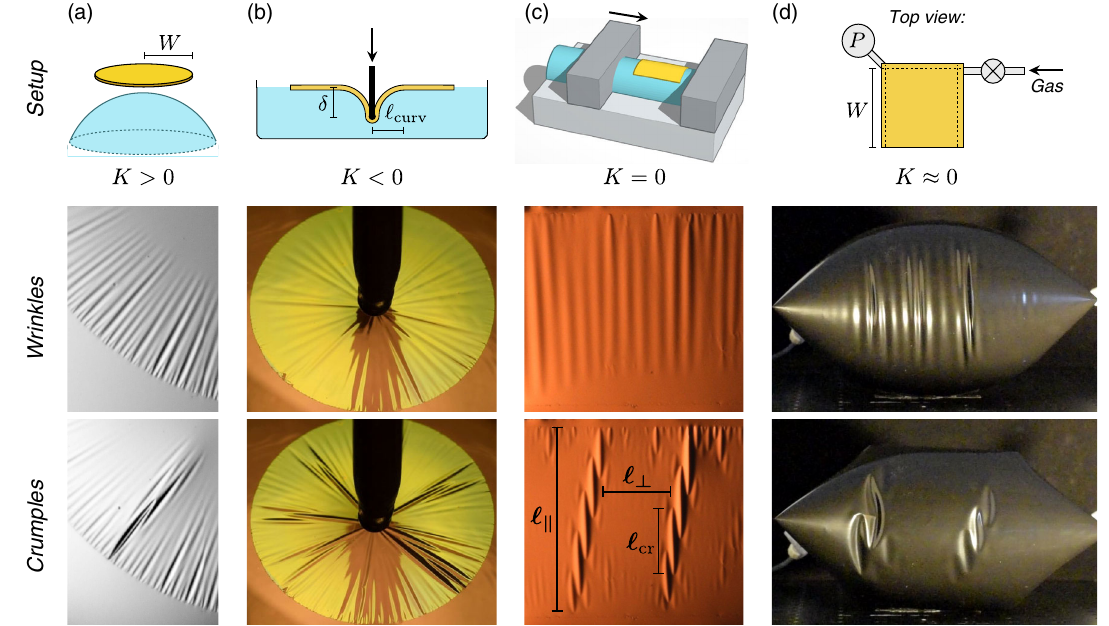
FIG. 1. Wrinkle-to-crumple transition in a wide range of geometries, boundary conditions, and system sizes. The overall Gaussian curvature K imposed on the relevant portion of the sheet is given below each schematic. (a) A circular polystyrene sheet ( E ¼ 3 . 4 GPa) of radius W ¼ 1 . 5 mm and thickness t ¼ 77 nm on a liquid meniscus forms crumples at a large droplet curvature [25]. Images adapted from Ref. [26] with permission. (b) A polystyrene sheet floating on a liquid bath forms crumples when indented beyond a threshold depth. Here, W ¼ 11 mm and t ¼ 436 nm. (c) Central portion of a rectangular polystyrene film of thickness t ¼ 157 nm, width W ¼ 3 . 3 mm, and length 9.7 mm on a water meniscus that is uniaxially compressed between two barriers. Wrinkles form when the meniscus is flat or gently curved; crumples form when the imposed curvature along the wrinkle crests is sufficiently large. (d) A square polyethylene bag ( t ¼ 102 μ m, E ¼ 210 MPa) forms wrinkles when inflated with sufficient internal pressure P . Crumples occur at a lower pressure. The deflated bag width is W ¼ 20 cm. Supplemental Movies 1 – 3 in [27] show the transitions in (b) – (d),